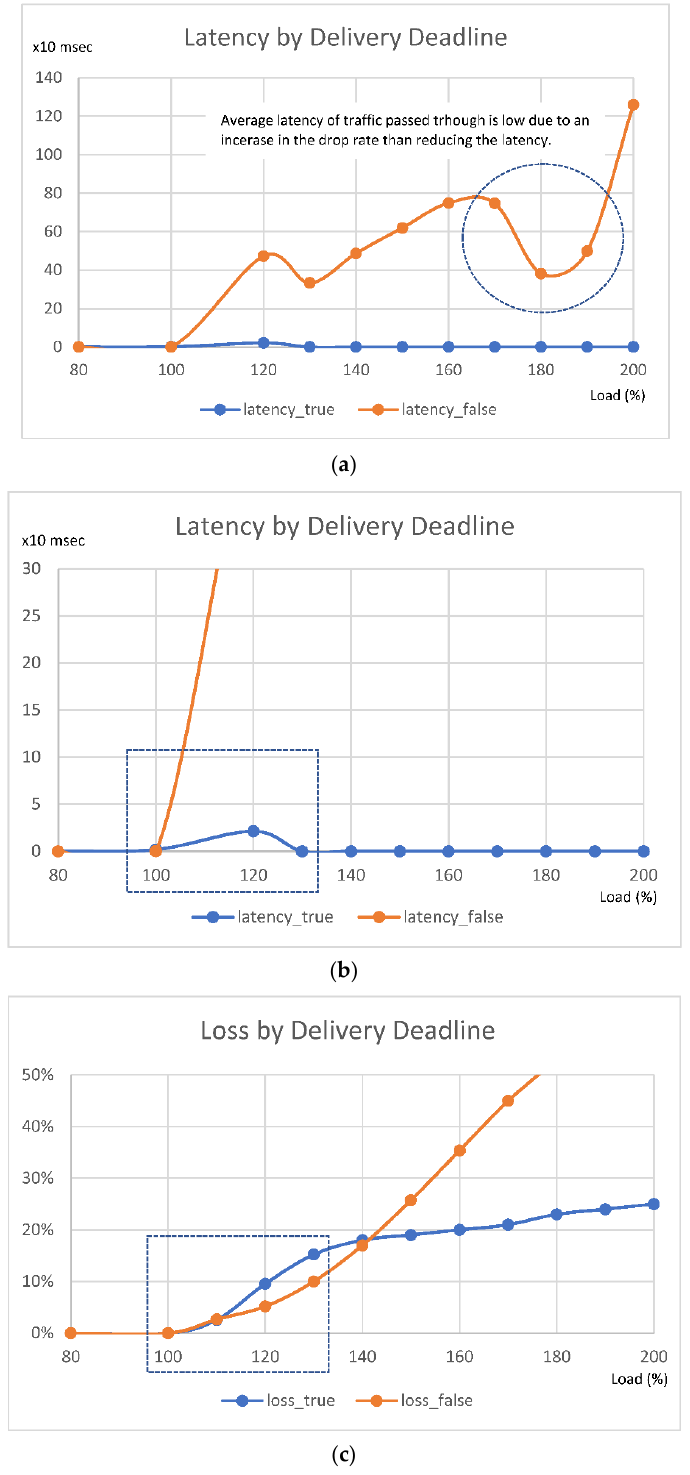
Figure 9. Performance results of delivery deadline: ( a ) Latency performance by delivery time-limit flags; ( b ) the meaningful period of ( a ); and ( c ) Loss performance by delivery time limit.